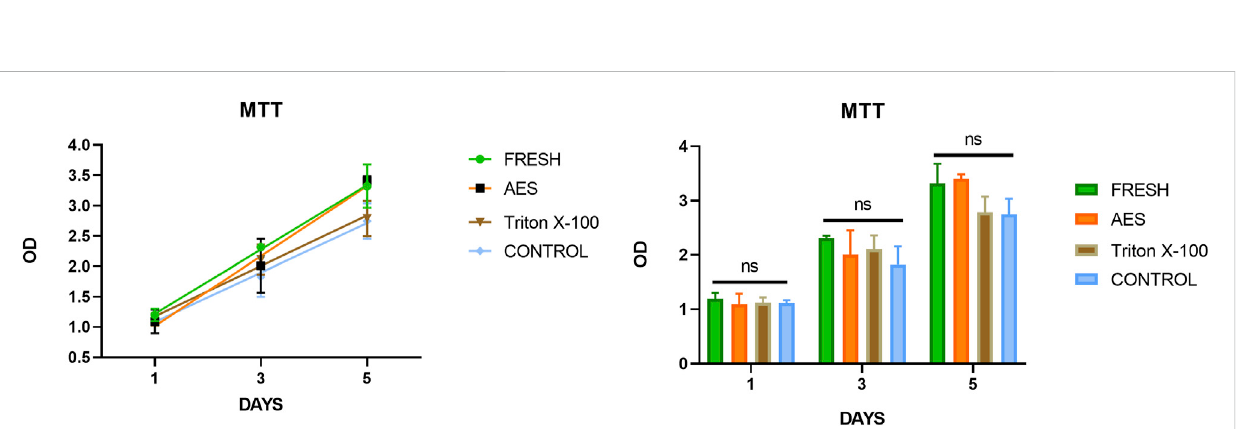
FIGURE 5 The cytotoxicities were determined by MTT assay, there was insigni fi cance of the relative growth ratio in the experiment groups and control groups ( p > 0.05).